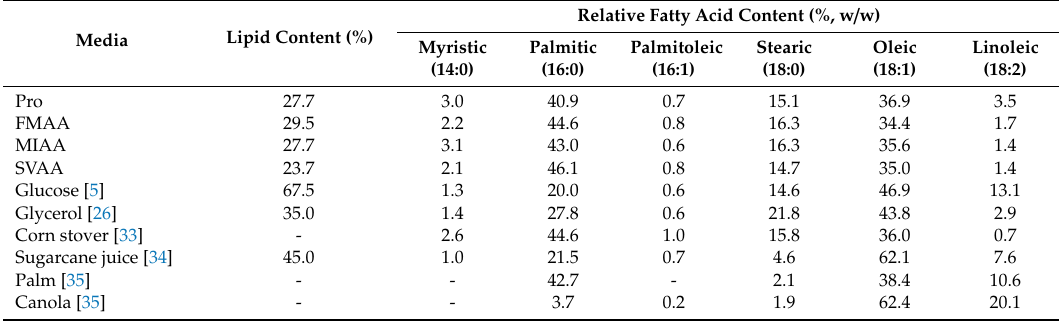
Table 2. Fatty acid compositional profiles of lipids produced on di ff erent substrates by R. toruloides and typical vegetable